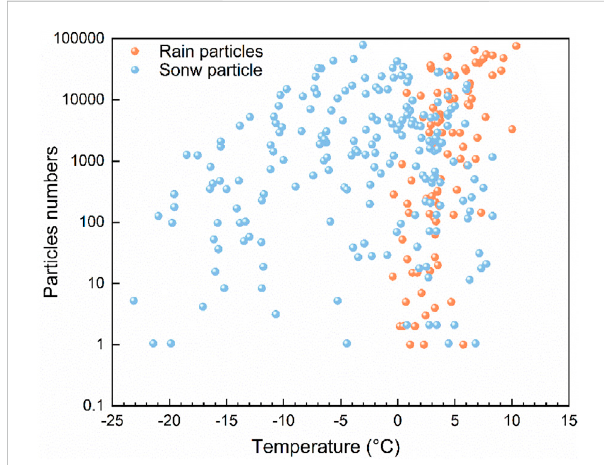
FIGURE 2 Distribution of rain and snow particles with the temperature in 2019.